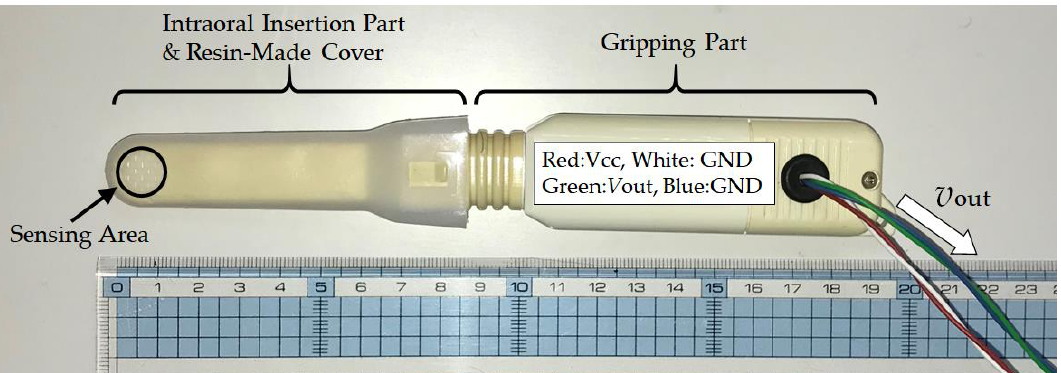
Figure 3. Appearance of the GM-10 occlusal force meter. This occlusal force meter is constructed continuously of an intraoral insertion part and a gripping part; 88 mm of the total length is the intraoral insertion part (on the left side in the figure) and the remaining 101 mm is the gripping part (on the right side in the figure). During measurements, the disposable resin-made cover is placed on the intraoral insertion part in advance. The subject then holds the gripping part using a single hand and the sensor measures the occlusal force when the subject chews the tip (i.e., the sensing area) of the intraoral insertion part.